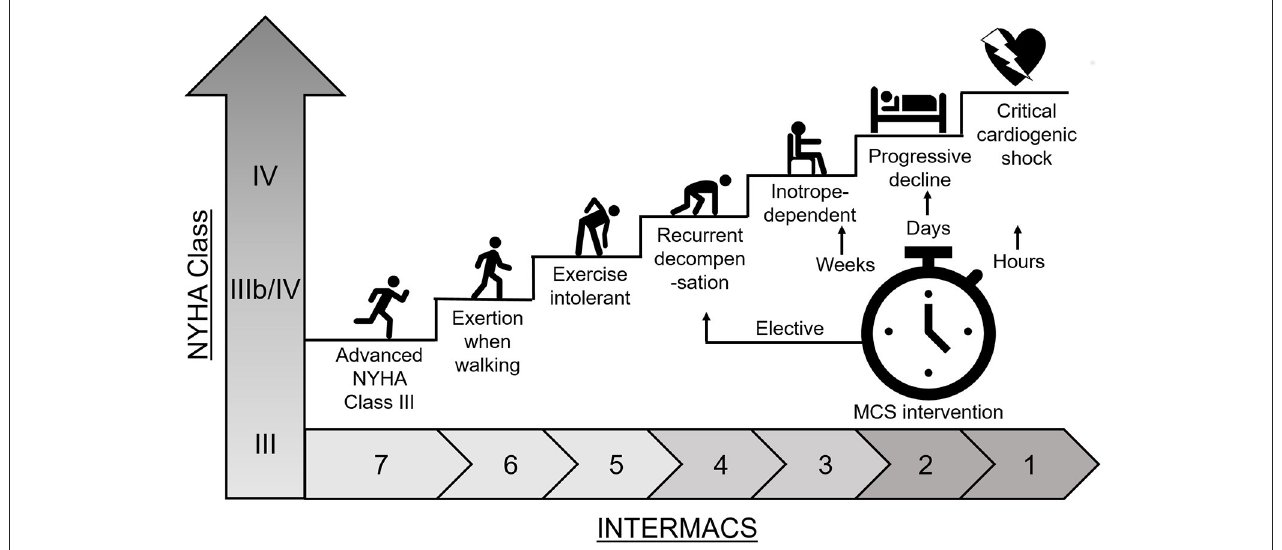
FIGURE 1 | Heart failure disease progression. Heart failure disease progression and INTERMACS profile for determination of patient treatment with mechanical circulatory support